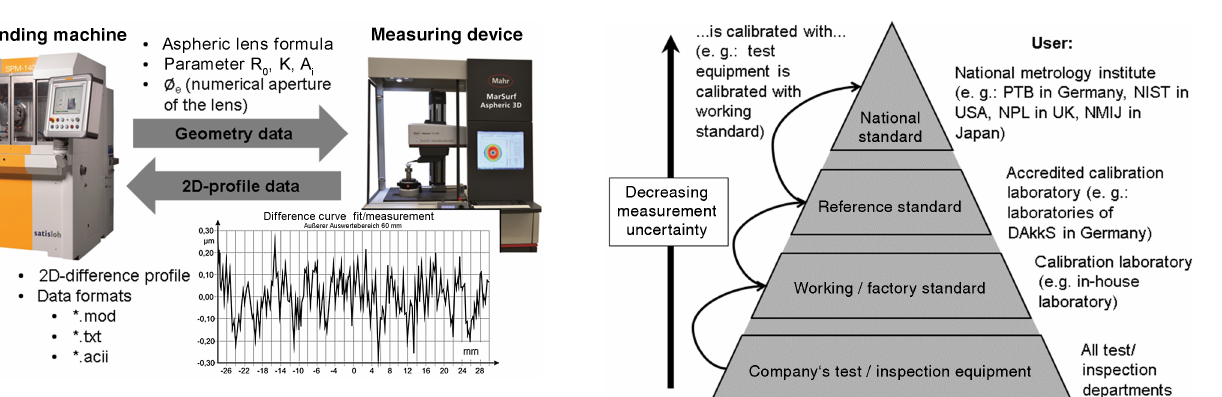
Figure 6. Calibration pyramid of the measurement traceability hi- erarchy (PTB – Physikalisch Technische Bundesanstalt, Germany’s national institute; NIST – National Institute for Standards and Technology; NPL – National Physical Laboratory; NMIJ – Na- tional Metrology Institute of Japan; DAkkS – Deutsche Akkredi- tierungsstelle, Germany’s accreditation